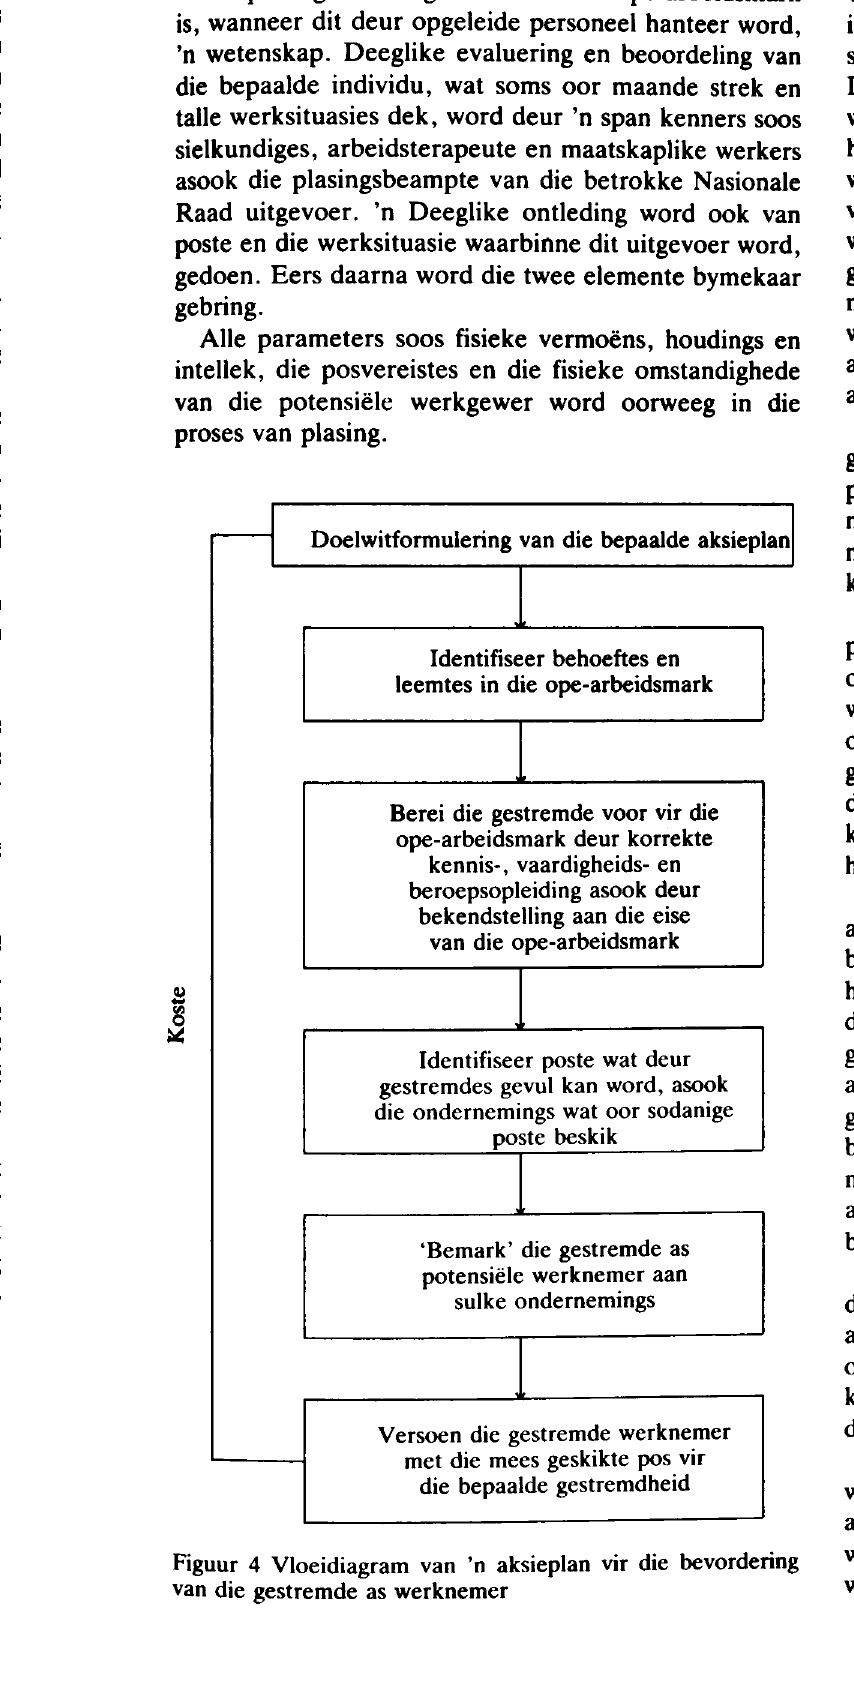
Figuur 4 Vloeidiagram van 'n aksieplan vir die bevordering van die gestremde as